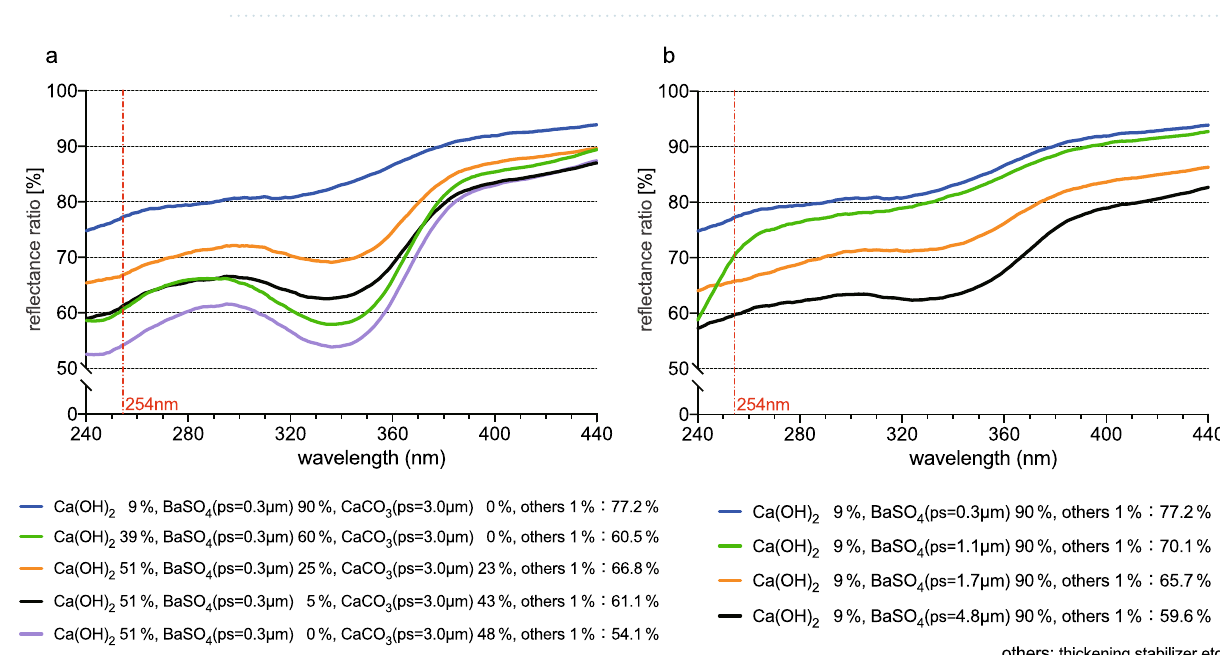
Figure 4. Reflectance ratios of UV lights by replacing CaCO 3 with BaSO 4 , ( a ) changed in weight % and ( b ) particle diameter of